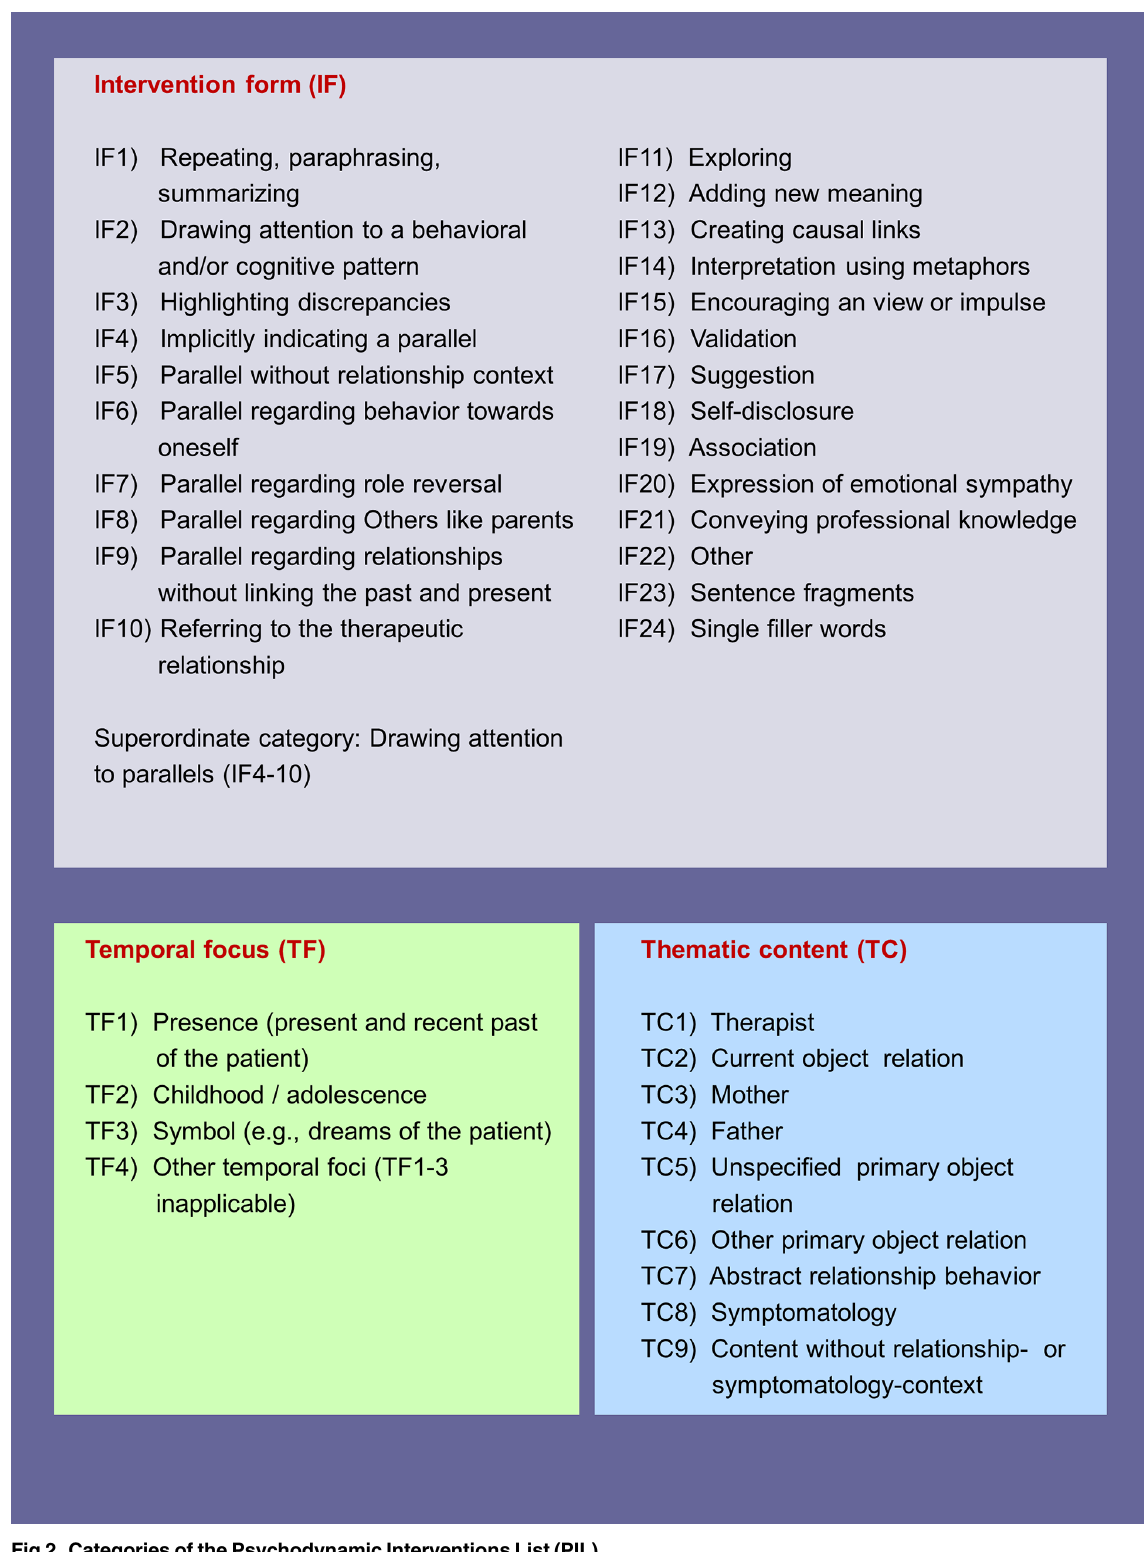
PLOS ONE | https://doi.org/10.1371/journal.pone.0182949 August 24,